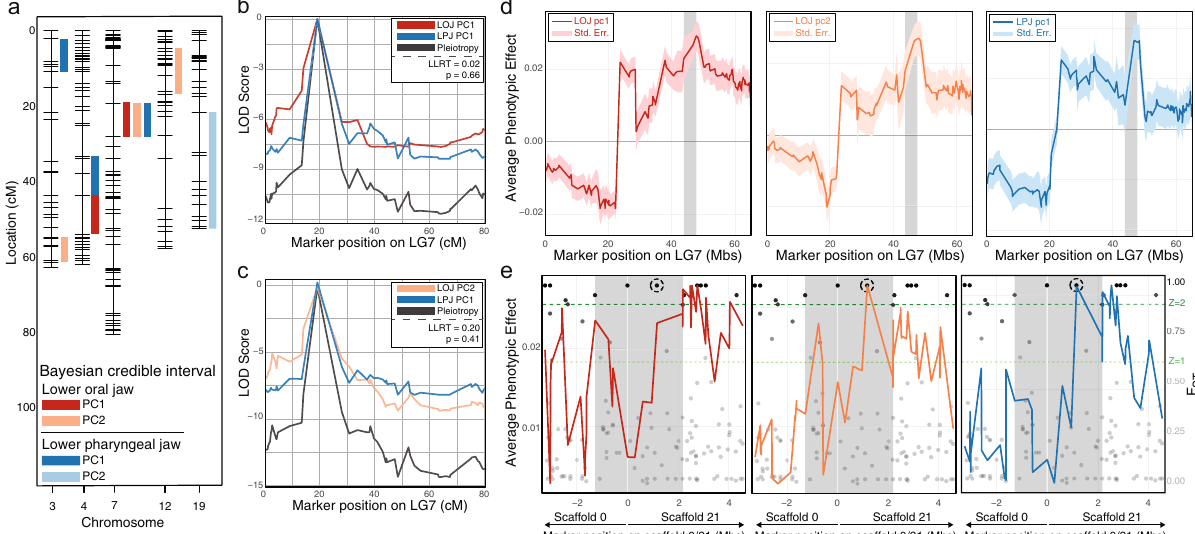
Fig. 4 Genetic analyses to identify regions of the genome responsible for major changes in jaw shape. All plots are based on 409 LFxTRC F 5 hybrids. a QTL analysis to identify positions in the genome most associated with each trait. b Pleiotropy analysis on linkage group seven to determine whether the oral jaw PC1 trait colocalizes to the same region as the pharyngeal jaw PC1 trait. Signi fi cance was determined using a likelihood ratio test (LLRT). c Pleiotropy analysis on linkage group seven to determine whether the oral jaw PC2 trait colocalizes to the same region as the pharyngeal jaw PC1 trait. Signi fi cance was determined using a LLRT. d Fine mapping all traits across the entirety of LG7. Values furthest from 0 re fl ect the largest differences between hybrids with LF and TRC genotypes at a given marker. We fi nd peak genotype-phenotype association at ~50 mb that coincides with our Bayes credible interval (grey bar). Intervals that surround the average phenotypic effect line denote standard error of the mean. e Fine mapping all traits across the Bayes credible interval. Population level genetic diversity (F ST ) data are applied to the map (black dots) with the opacity of each SNP dependent on the degree of segregation between LF and TRC, with those falling above an empirical Z -score threshold of 0.6 determined to be signi fi cant, and those above 0.9 deemed highly signi fi cant (green lines). Within the credible interval there are four SNPs with F ST values of 1.0, but a single SNP that falls within a